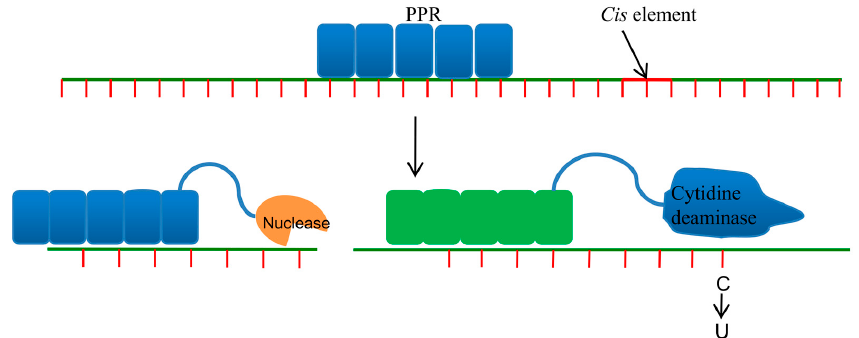
Figure 4. RNA editing by pentatricopeptide repeat proteins (PPR). PPR proteins with a nuclease or a cytidine deaminase domain trigger RNA modifications as shown.